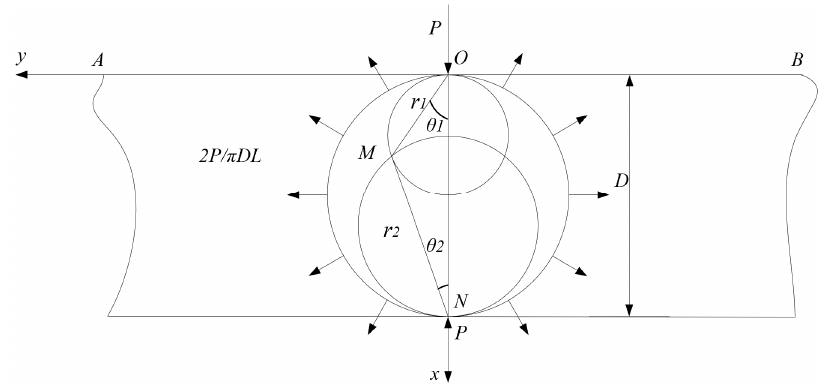
Figure 8. Force state of the Brazil disc.